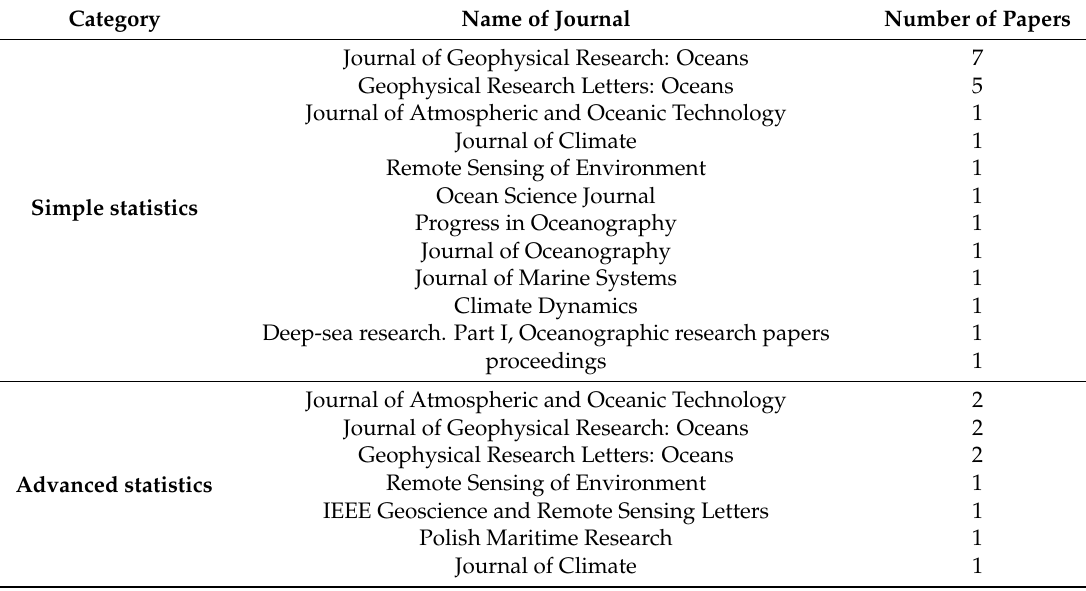
Table 1. Relevant journals and conference proceedings that have published studies related to ocean/sea subsurface water temperature in remote sensing scope. The search was conducted on 1 December 2016.